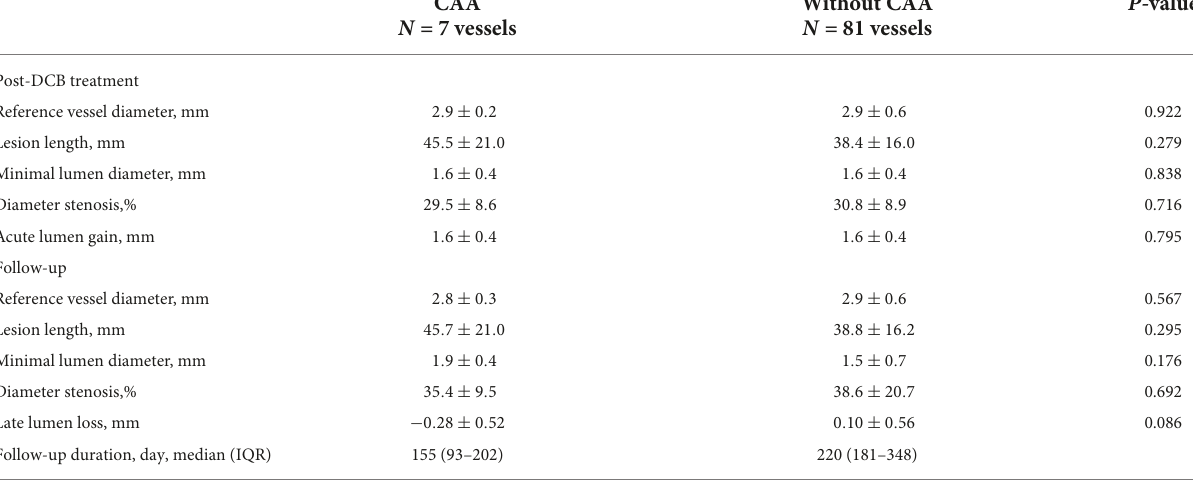
TABLE 3 Quantitative coronary angiography according to the presence of aneurysm after DCB-only